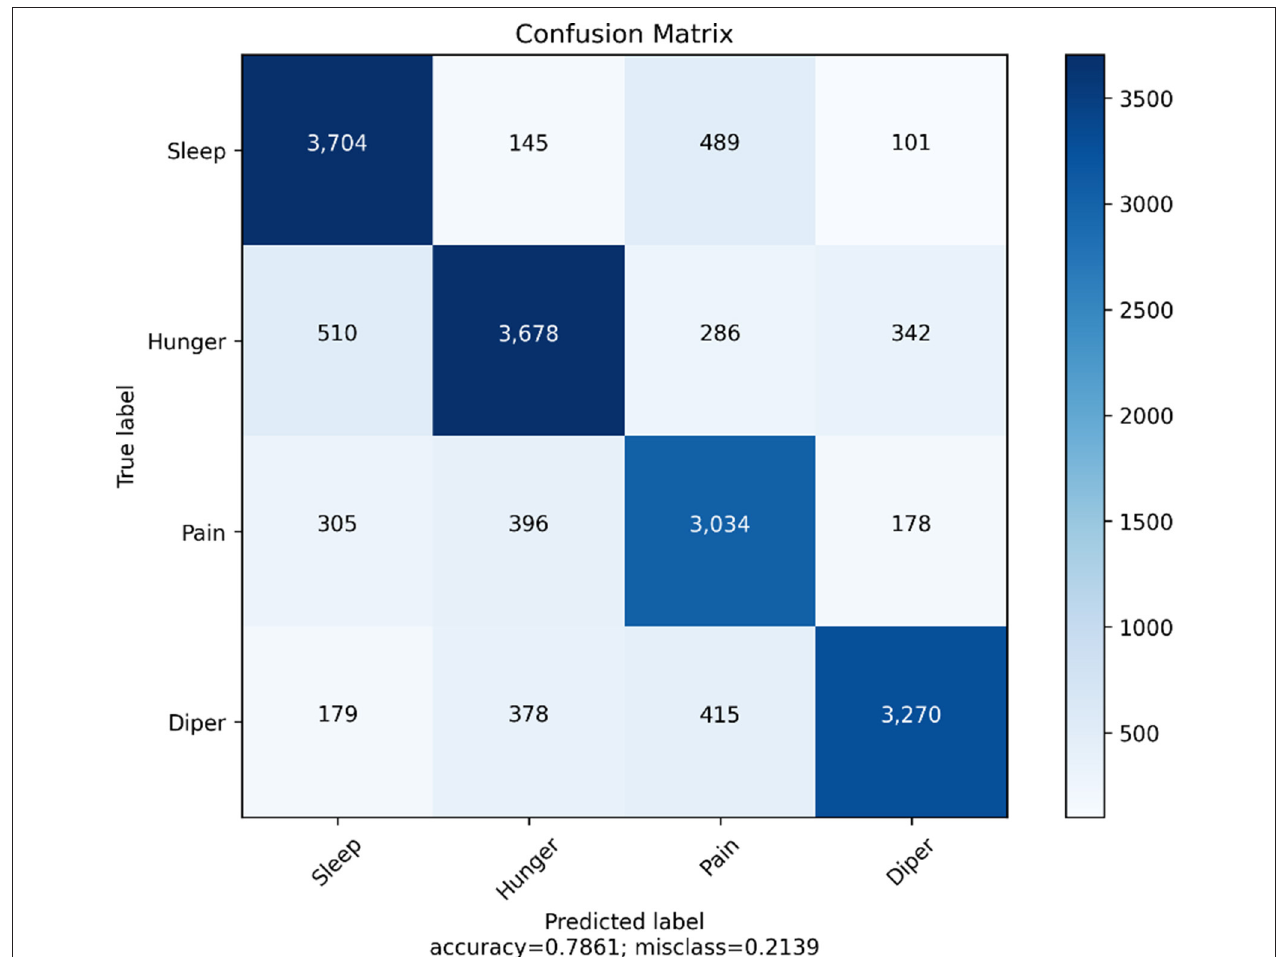
FIGURE 11 | Confusion matrix for the YOLOv4 model.